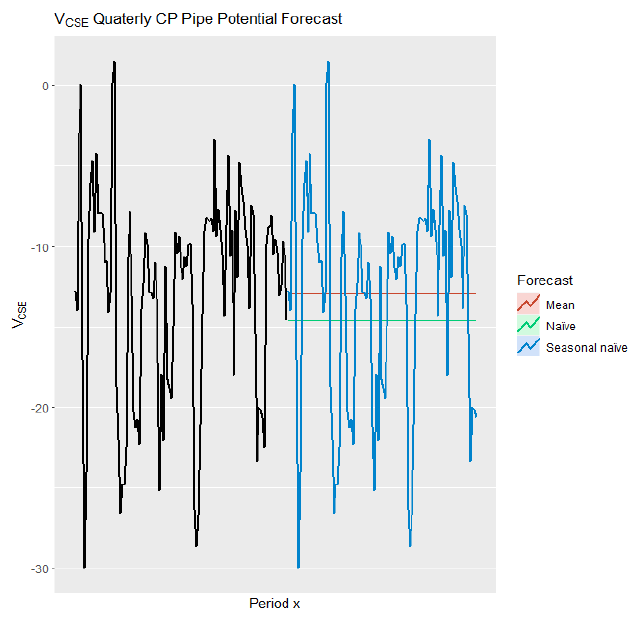
Figure 20. Quarterly forecasted CP pipe potential.